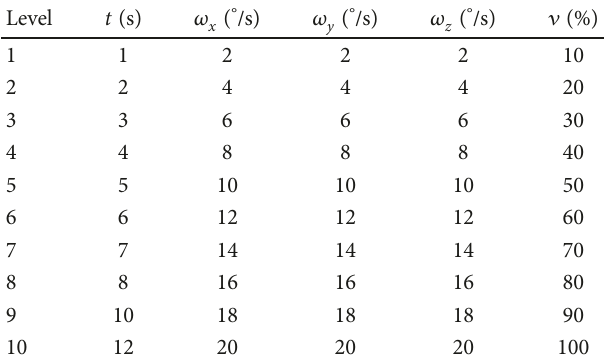
Table 6: Parameter-level table.